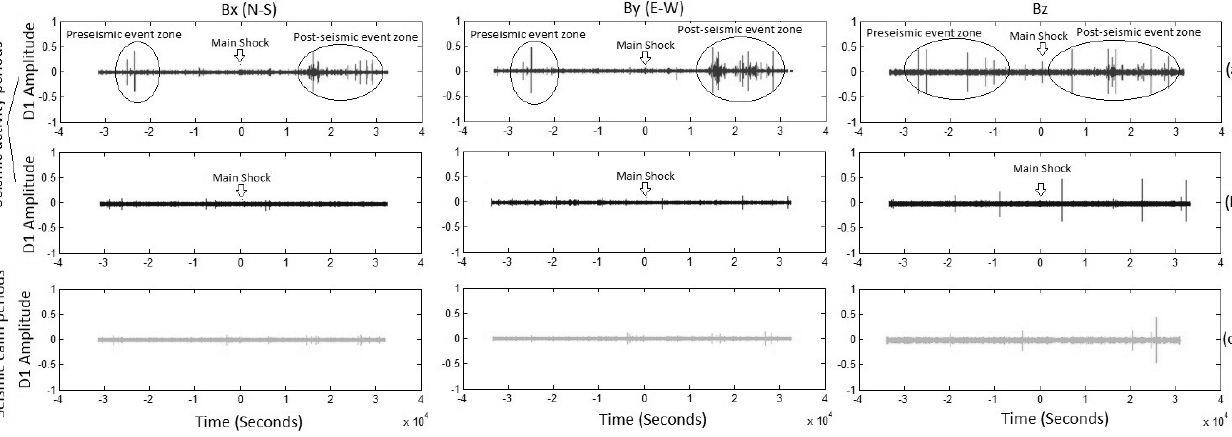
Fig. 3. Wavelet Discrete Transform of the three geomagnetic components in superposed epochs for the three conditions of seismic activity in the ULF frequency range f = 0 . 25 − 0 .